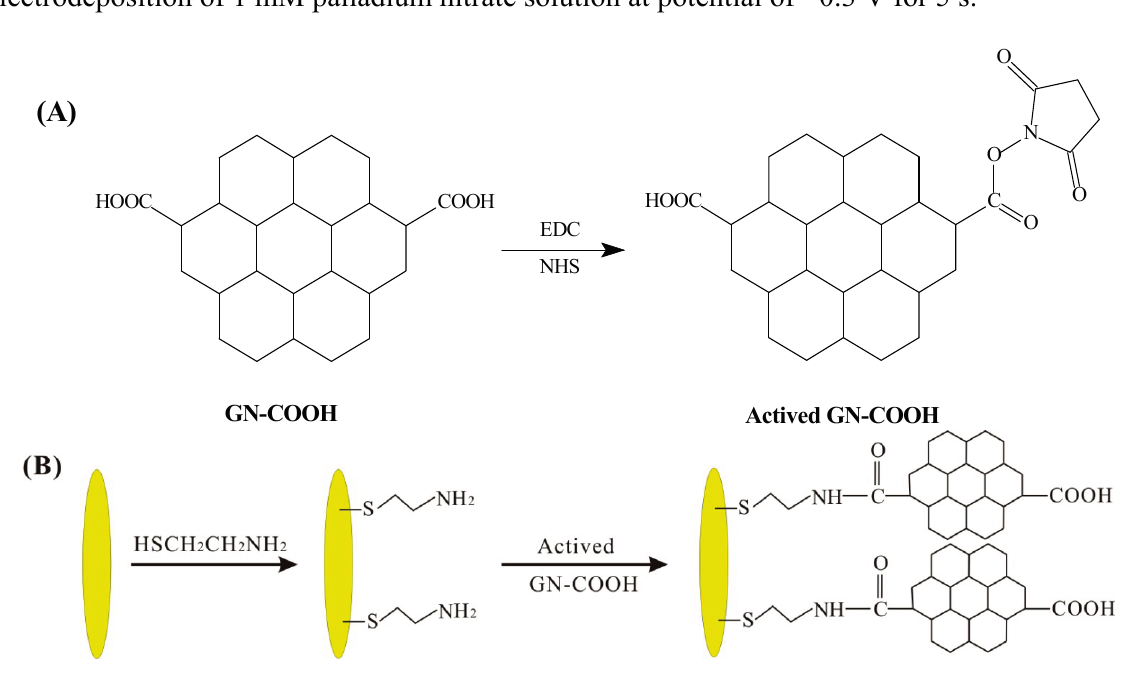
Figure 2. The scheme of active carboxylic group ( A ) and the modification process of GN-COOH on UMEA ( B ).